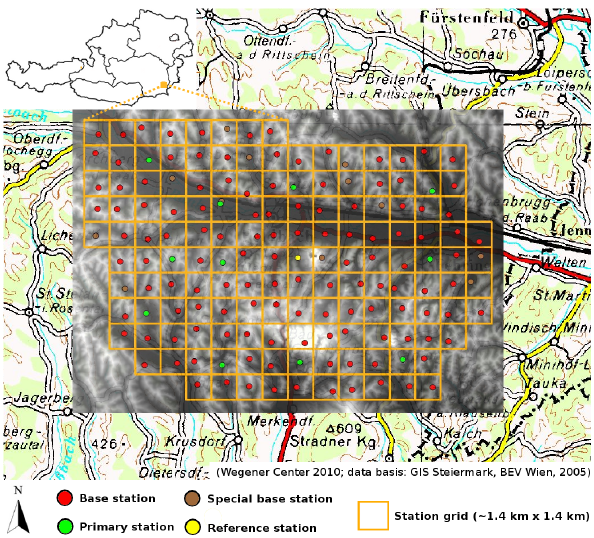
Figure 2. Setup of the WegenerNet climate station No. 6 during the year